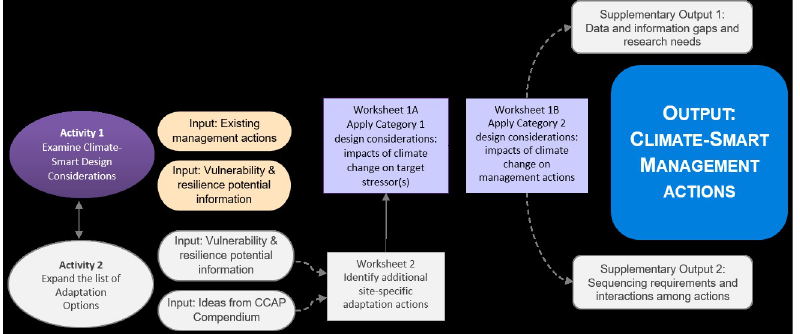
Fig 2. Flow chart of the Adaptation Design Tool [15]. Outputs from worksheets 1A and 1B from this case study can be found in S3 Table. Activity 2 and supplementary outputs have been faded in the figure, as they were not part of this study. The CCAP (Corals and Climate Adaptation Planning) Compendium, a thematically organized compilation of adaptation options for coral reefs, can be found in [6].